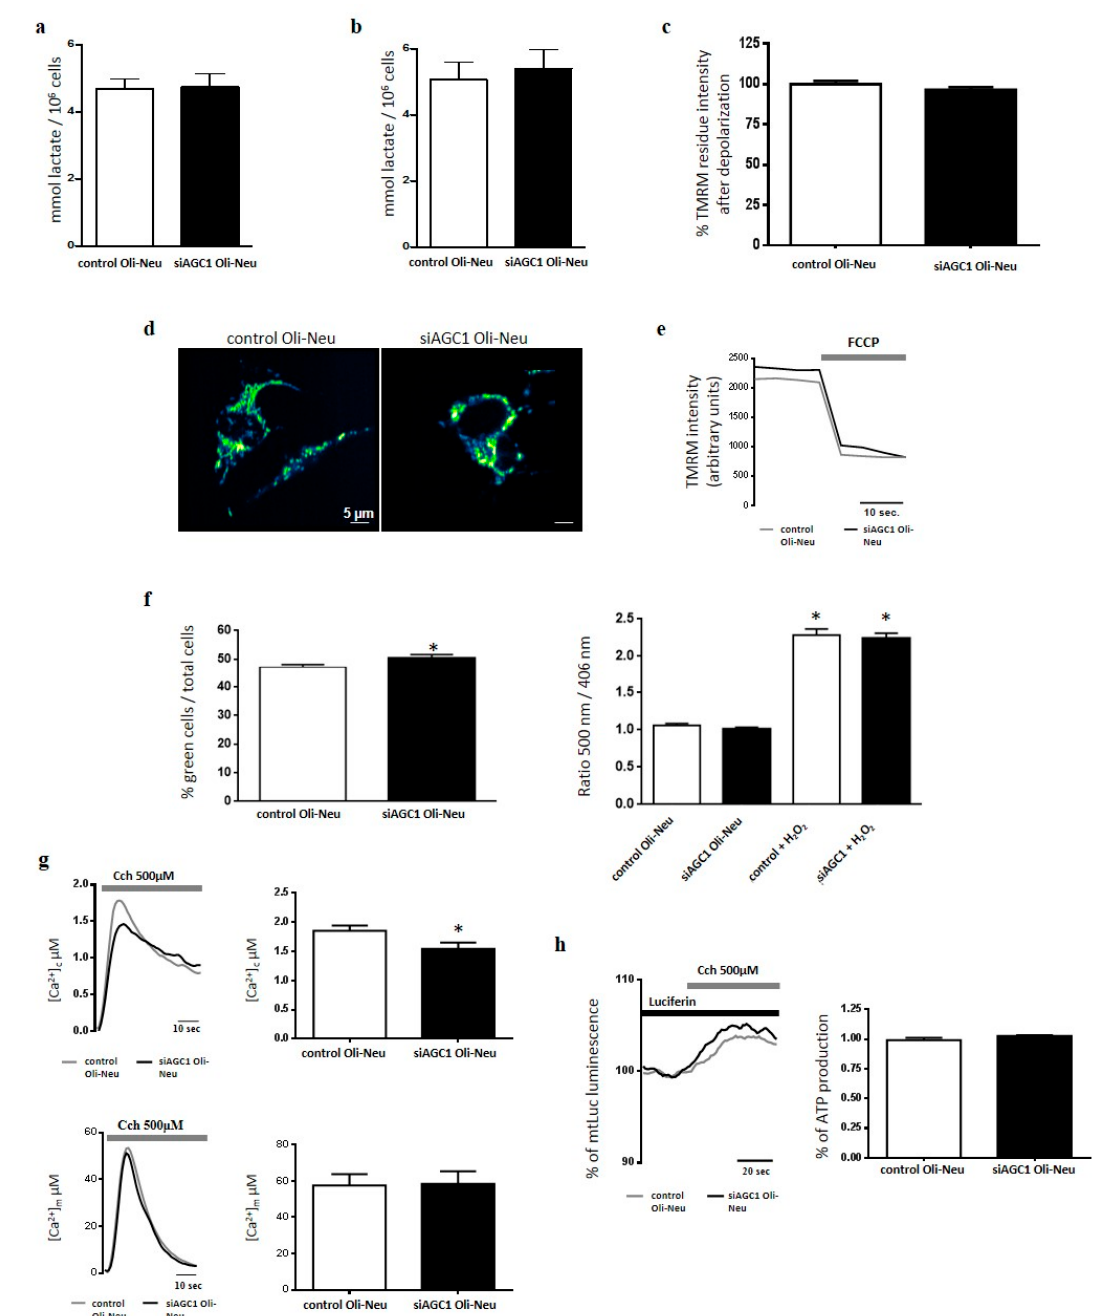
Figure 2. Effect of AGC1 down-regulation on lactic acid release, mitochondrial membrane potential, ROS generation and [Ca 2+ ] homeostasis of Oli-Neu cells. Lactic acid was quantified in conditioned complete SATO mediumharvested from control Oli-Neu (white bars) or siAGC1-Oli-Neu cells (black bars) in the absence ( a , undifferentiated cells) or presence ( b , differentiated cells) of 1 mM dibutyryl- cAMP for 48 h. Values are the means ± SD from 3 independent experiments performed in triplicate. ( c ) ∆ ψ m was measured by fluorescence microscopy in control Oli-Neu (white bars) or siAGC1-Oli-Neu cells (black bars) incubated in minimal essential medium supplemented with 1 g / L glucose. Cells were loaded with 20 nM TMRM (tetramethyl rhodamine methyl ester) for 30 min at 37 °C and fluorescence intensities were imaged every 5 s with a fixed 20 milliseconds exposure time. Carbonyl cyanide-4-(trifluoromethoxy)phenylhydrazone (FCCP), an uncoupler of oxidative phosphorylation, was added after 12 acquisitions to completely collapse the electrical gradient established by the respiratory chain ( d , e ). Data are means ± SD of TMRM percentage intensities normalized to values before agonist stimulation in three independent experiments. ( f ) Cytosolic and mitochondrial